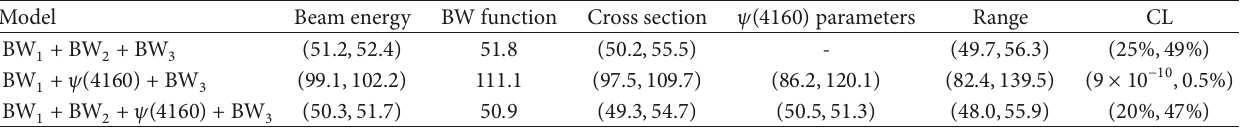
Figure 2: The fits to the cross section of 𝑒 + 𝑒 − → 𝜂𝐽/𝜓 from BESIII and Belle experiments; two solutions are found and are shown in plots (a) and (b). The solid red curves show the best fits, and the dashed green ones are individual components. Table 2: The goodness-of-fit values for different systematic uncertainty terms in different models, where 𝑛𝑑𝑓 has not been divided. 𝑛𝑑𝑓 are 50, 52, and 48 for models BW 1 + BW 2 + BW 3 , BW 1 +𝜓(4160)+ BW 3 , and BW 1 + BW 2 +𝜓(4160)+ BW 3 , respectively. The first value in brackets is the minimum value for different situations, and the second value is the maximum. The column “Range” is the range of goodness-of-fit values for all different systematic uncertainty situations, and the column “CL” is the range of confidence levels corresponding to the value in the column “Range.”